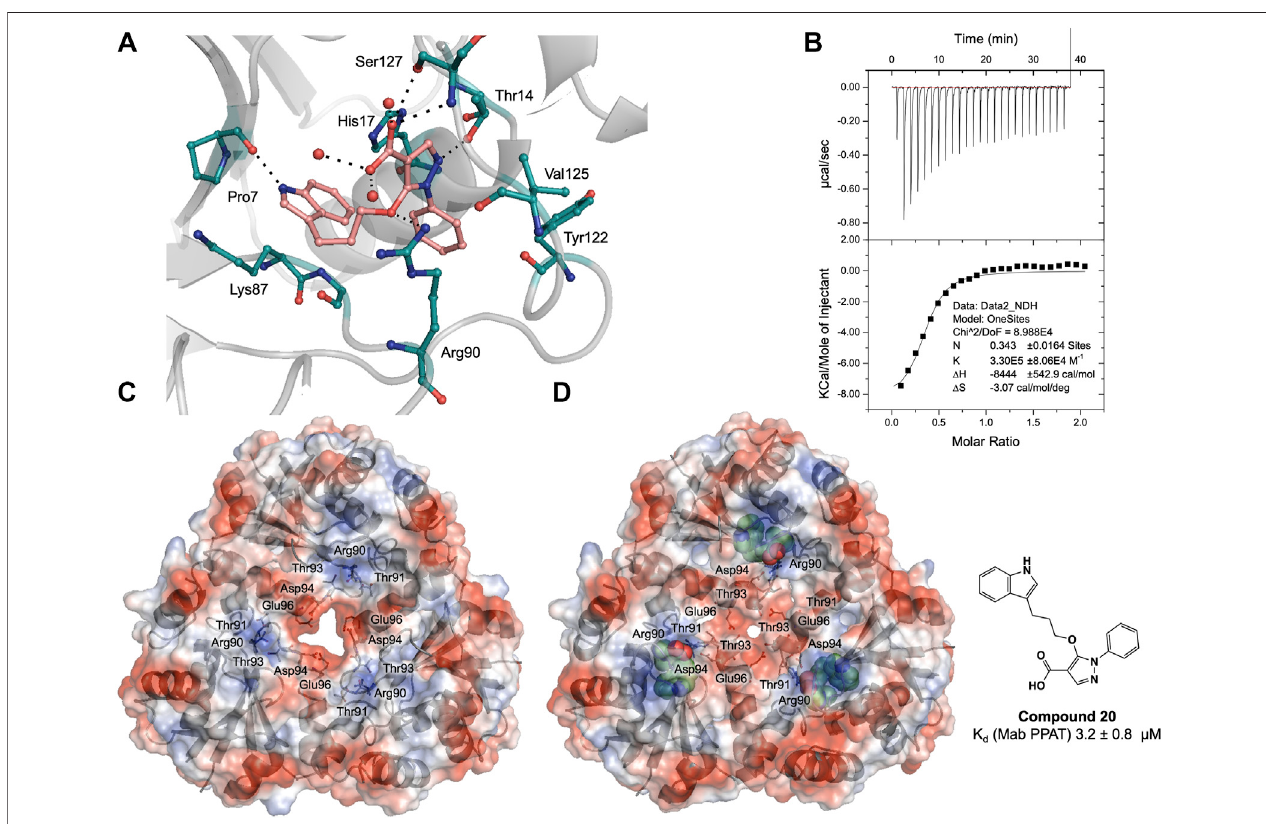
FIGURE 4 | (A) Active site diagram showing binding interactions of compound 20 (salmon stick model) with Mab PPAT (grey). The interacting residues are shown as green stick representation. Polar hydrogen bond contacts are shown in black dotted lines and active site water molecules as red spheres. (B) Thermodynamic (ITC) pro fi lesofcompound 20 interactionwith Mab PPAT.Surfaceelectrostaticrepresentation of M.abscessus PPATillustrating (C) apo Mab PPAT(PDBcode5O06)having anopenandpredominantlynegativelychargedsolventchanneland (D) Compound 20 (greensphericalrepresentation)boundformwithclosedconformationofthe central solvent channel (PDB code 7YYZ). The key amino acid residues mediating the conformational switch are shown as grey stick model.